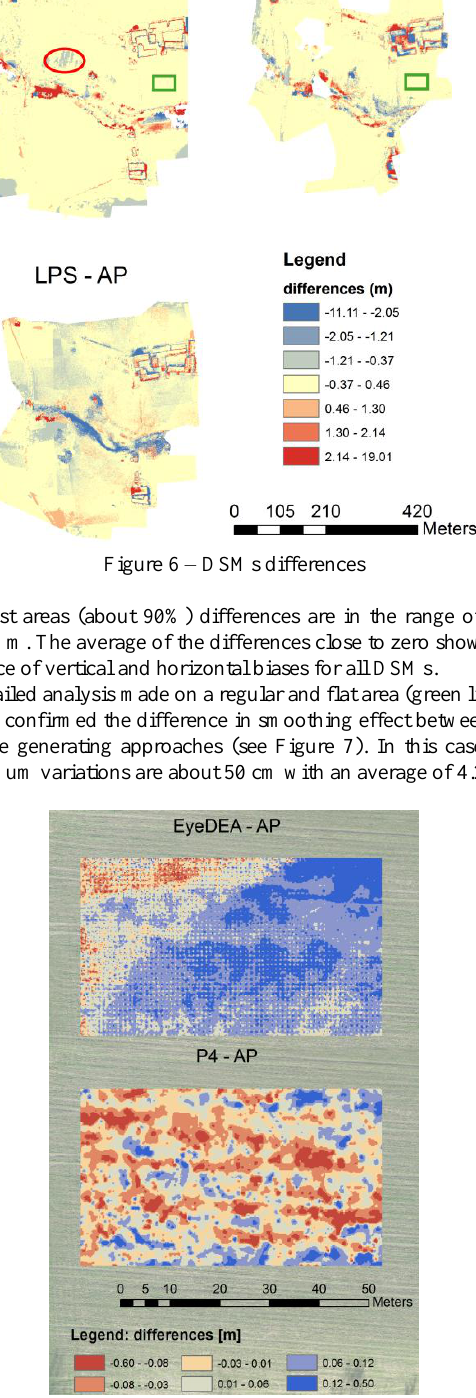
This contribution has been